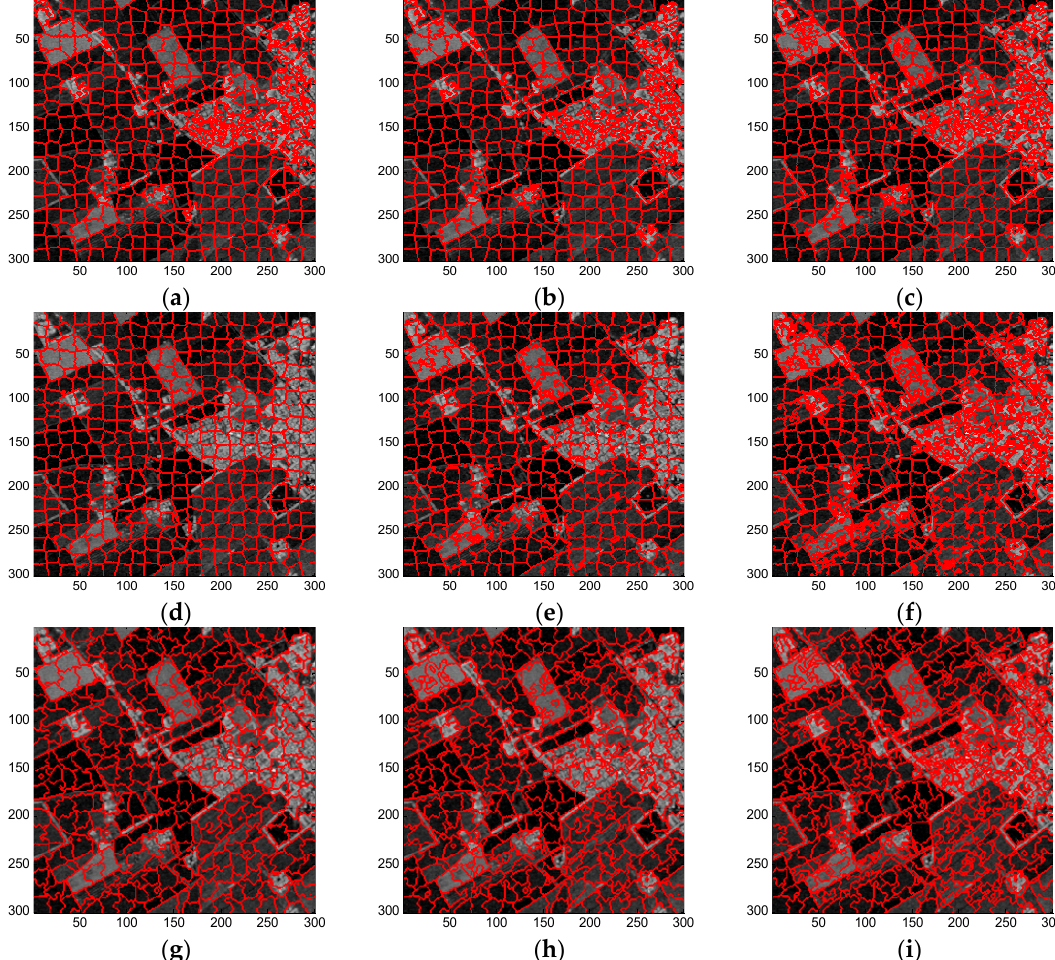
Figure 8. Superpixels of EMISAR image yielded by ( a – c ) standard SLIC algorithm; ( d – f ) compound method; and ( g – i ) proposed algorithm with regularization parameter w as 0.3, 0.6, and 0.9 from left to right.